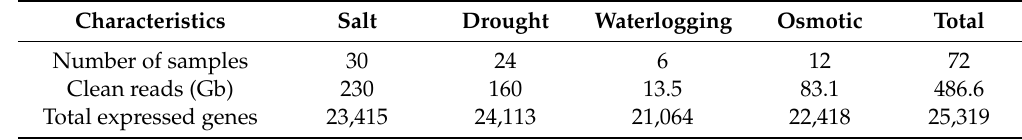
Table 1. Characteristics of the RNA-Seq datasets used in this